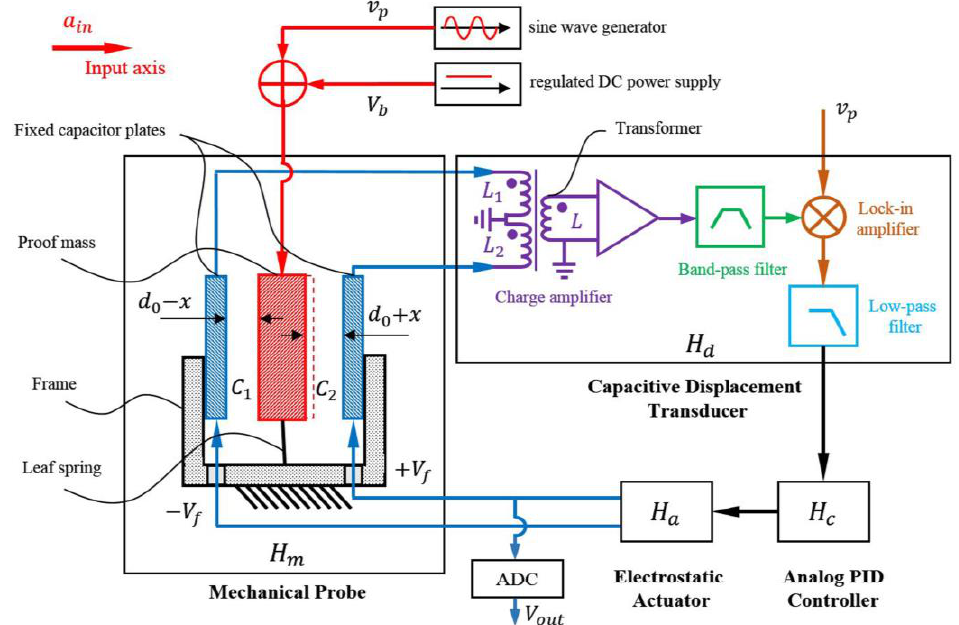
Figure 1. Schematic of the electrostatic accelerometer system. 𝑎 𝑖𝑛 is the external input acceleration. 𝑑 0 is the gap of the balanced capacitor 𝐶 0 and 𝑥 is the displacement of the proof mass. 𝐶 1 and 𝐶 2 are the differential detecting capacitors. 𝐿 1 and 𝐿 2 are the inductances of the transformer’s primary windings, while 𝐿 is that of the secondary. 𝐻 𝑚 , 𝐻 𝑑 , 𝐻 𝑐 , and 𝐻 𝑎 denote the transfer functions of the mechanical probe, the capacitive displacement transducer, the analog proportional-integral-differential (PID) controller and the electrostatic actuator, respectively.